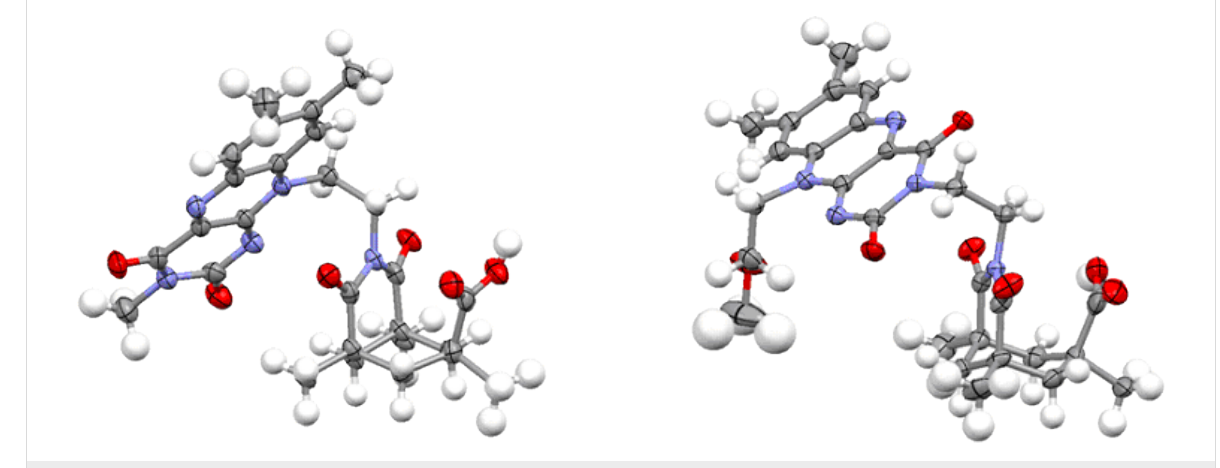
Figure 1: X-ray crystal structures of the flavin-Kemp’s acids 6 (left) and 9 (right).